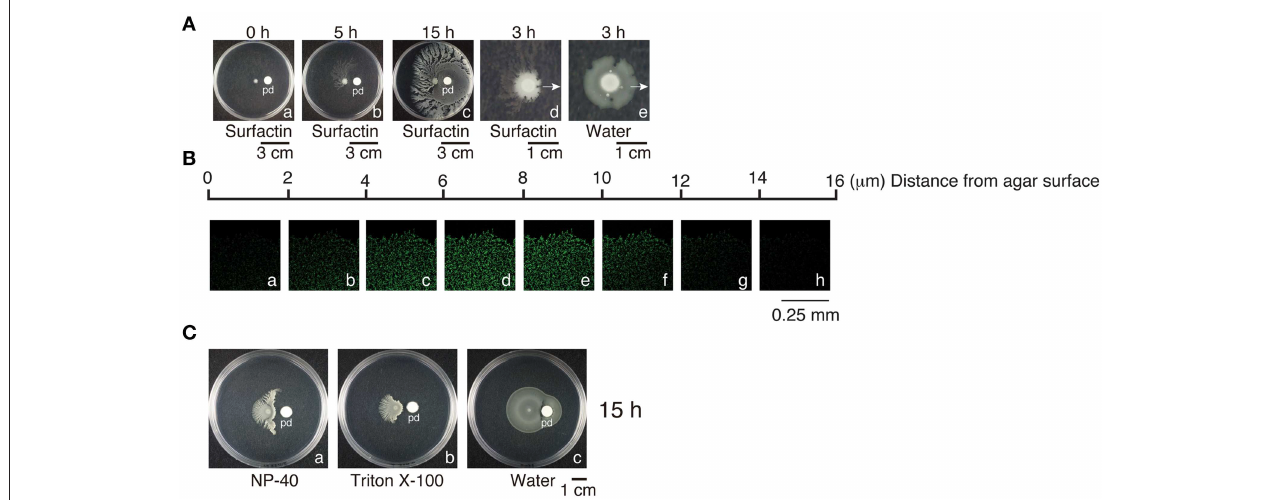
FIGURE 5 | Water surface tension and swarming. (A) Paper discs (pd), to which surfactin (100 µ l, 0.025%) (a–d) or 100 µ l water (e) had been applied, were placed 1.5cm away from the center of B. subtilis F29-3 colonies that had been cultured for 6h on 8.5-ml LB-0.4 agar plates. Colonies were photographed at selected time points within 0–15h after applying surfactin. Arrows indicate the direction of paper disc. (B) A paper disc with surfactin was placed 1.5cm from the center of a 6-h B. subtilis F29-3(pHag-gfp) colony. The bacteria were cultured for an additional 2h. Z stacks of the edge of the colony facing the paper disc, with planes separated by 2 µ m, were acquired using a confocal laser-scanning microscope. (C) Filter paper discs, to which NP-40 (a) , Triton X-100 (b) (100 µ l, 0.025%), or 100 µ l of water (c) were respectively applied, were placed 1.5cm from the center of B. subtilis F29-3 colonies cultured for 6h. Plates were incubated for